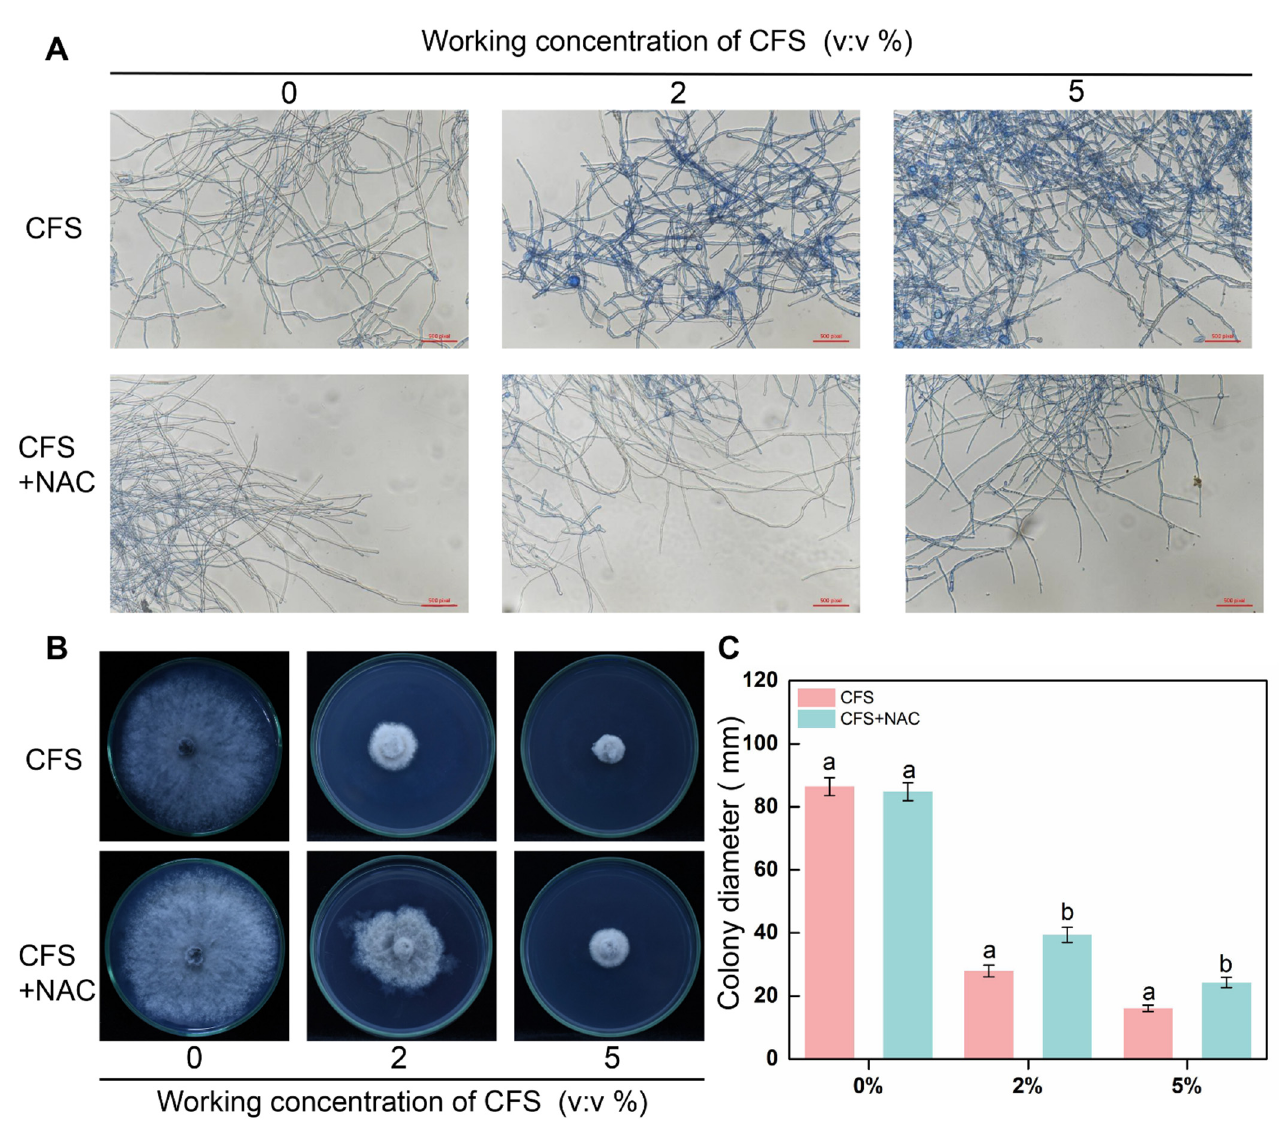
Figure 7. Effect of N-Acetylcysteine (NAC) on the activity and growth of mycelia treated with CFS. The cultures were amended with CFS (2% and 5% v/v ) and 10 mM NAC, separately. ( A ) Hyphal cell death was determined by an accumulation of staining with trypan blue after the application of CFS and treatment with NAC for 24 h. Images were recorded using a microscope. ( B ) The mycelial growth diameter was measured, and images were recorded 5 days after inoculation. ( C ) Statistical analysis for colony diameters. Error bars indicate standard errors of the means of two repeated experiments. Treatments annotated with different letters were significantly different within a specific time point according to the Duncan’s multiple range test. ( p < 0.05).